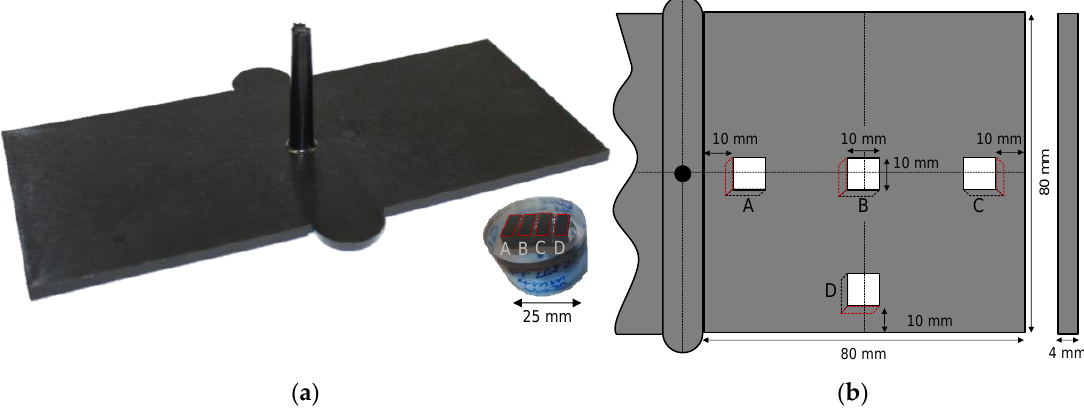
Figure 11. Injection molded plates ( a ) and scheme of evaluation points along one side of the plate ( b ).